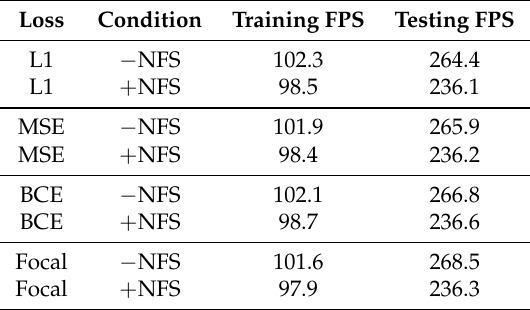
Table 1. Comparison of the computational efficiencies of different loss functions under conditions that with or without